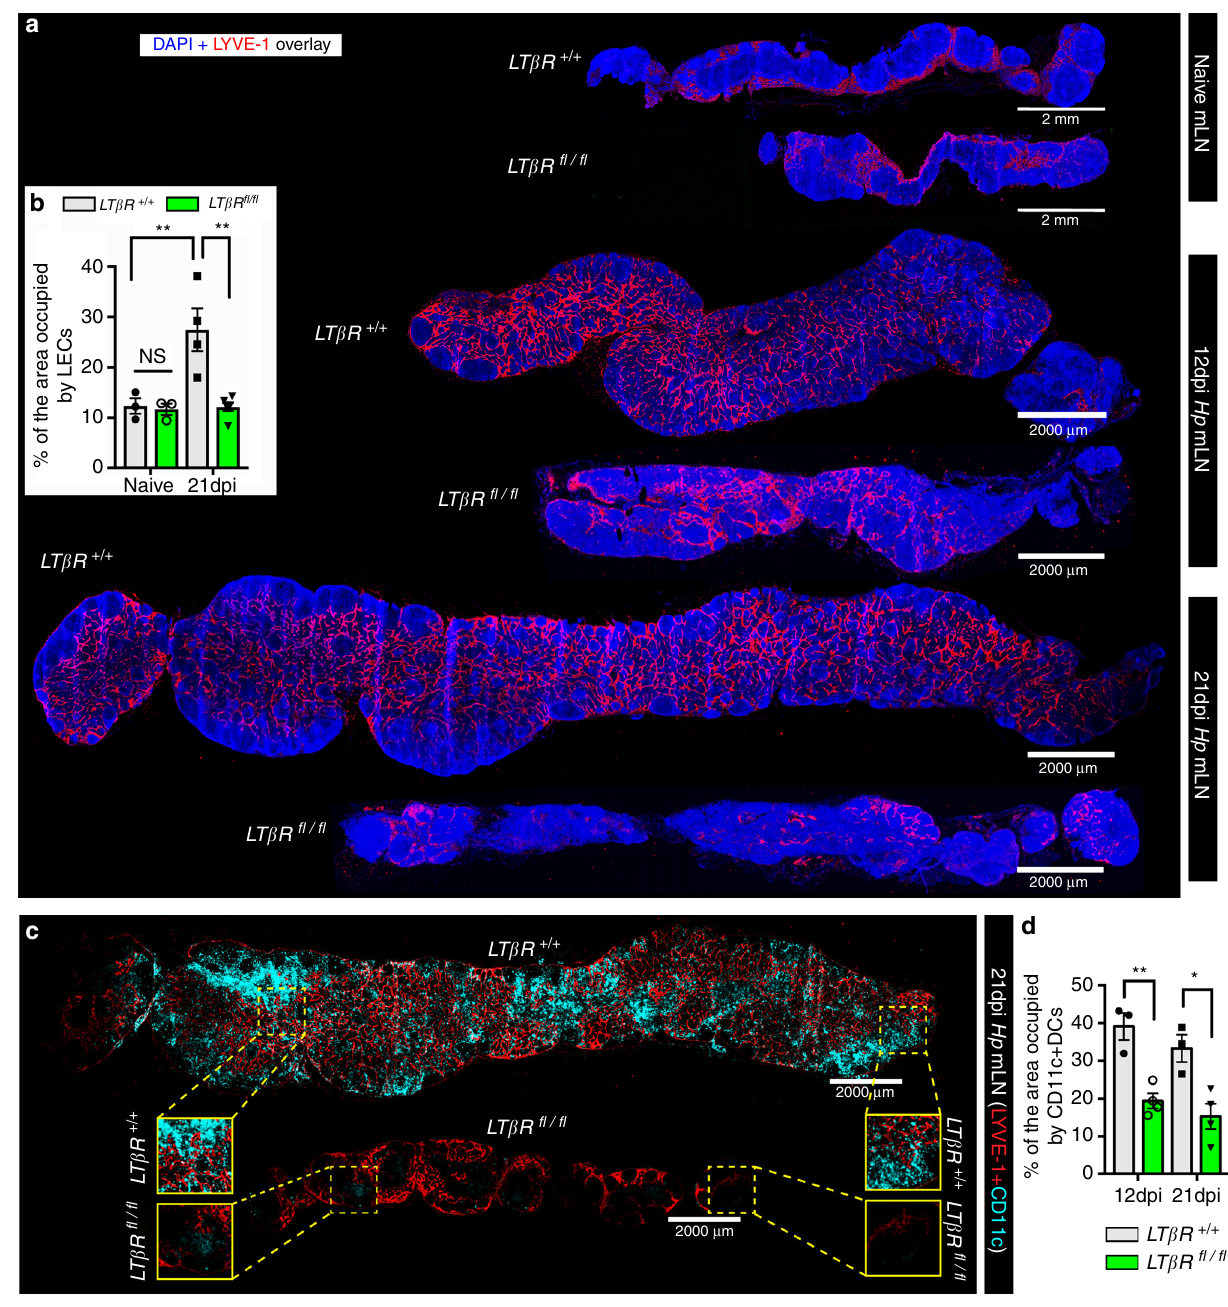
Fig. 3 LT β R expression by Ccl19 − cre -positive stromal cells is required for mLN lymphangiogenesis . Ccl19 − cre × LT β R fl / fl ( LT β R fl / fl ) and wild-type